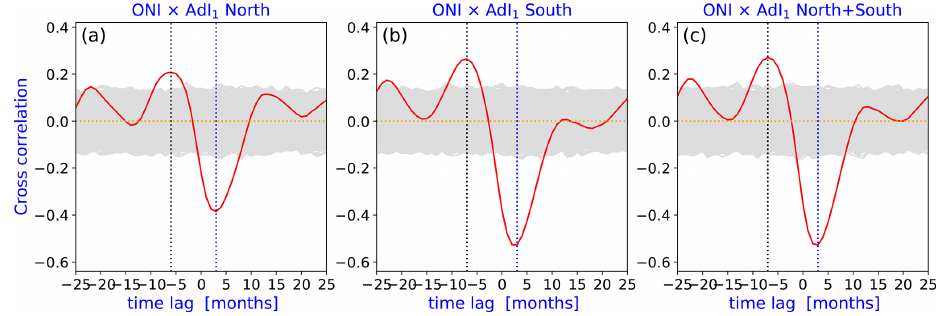
Figure 4. Cross-correlation between ONI and the monthly advection index AdI 1 for the northern and southern subsets of advected parcels (red). Dashed blue/black line indicates the time lag at which the cross-correlation is at its absolute minimum / maximum. The gray band indicates the 99% confidence interval, as described in Sect. 2. (a) AdI 1 for the northern subset (see Fig. 2a). (b) AdI 1 for the southern subset (see Fig. 2b). (c) Cross-correlation between ONI and the monthly advection index AdI 1 for all the westward-moving parcels. The strongest anticorrelation occurs at + 3 months in each case, meaning that the advection strength AdI 1 leads ONI: a marked weakening of advection is followed by a warming SST signal with a delay of 3 months, and vice versa.)